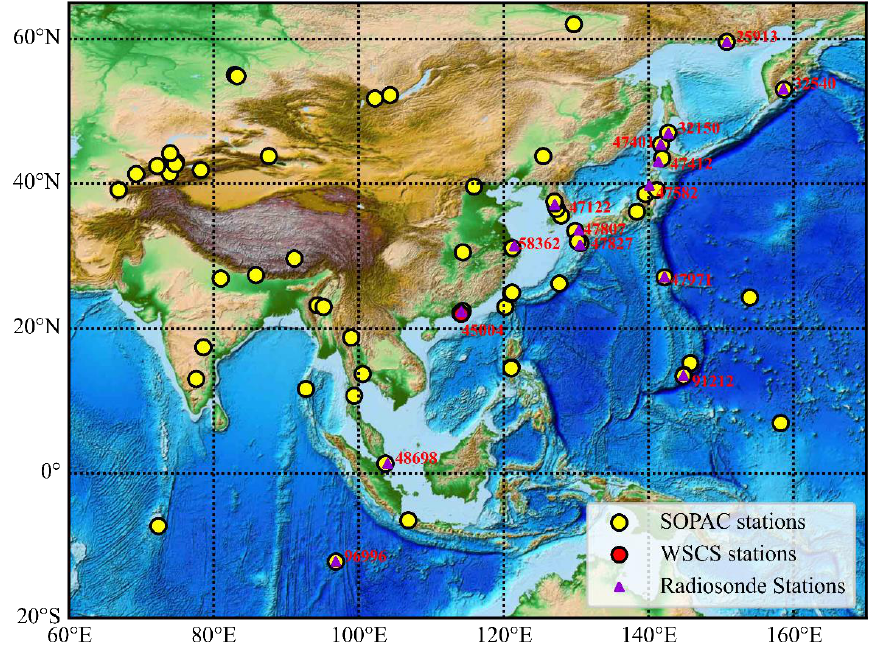
Figure 1. Sketch of the dataset in this research. The yellow circles represent the PGS observations from the GRC used for PGS processing. The dark-violet triangles represent the radiosonde stations used for comparisons with the ZWD of GNSS stations. The red numbers represent the ID number of the radiosonde. The red circle represents the permanent GNSS stations of the WSCS, which is close to the radiosonde (ID: 45004).